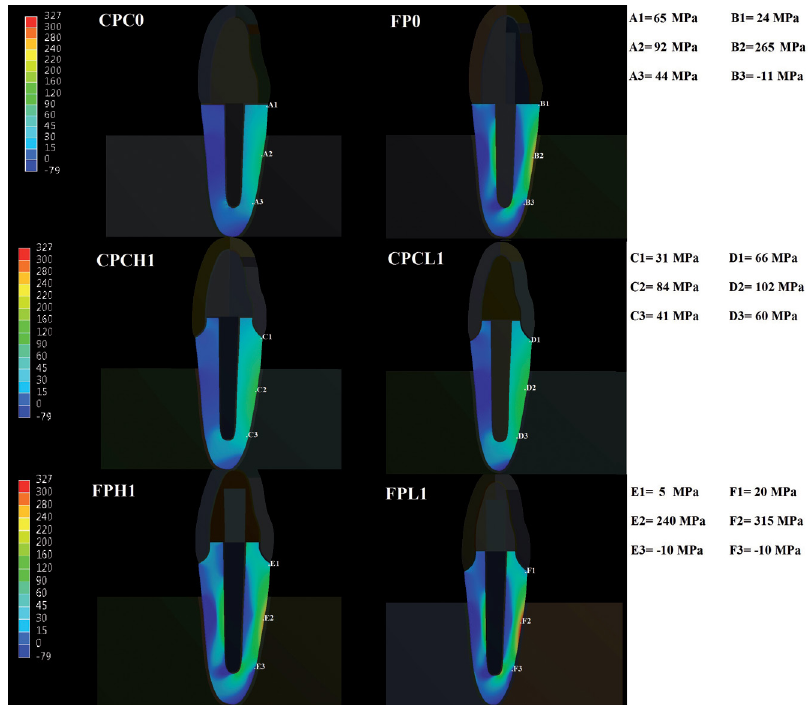
Figure 6- The images above shows: higher values of tensile stress at external portion of the root, in cervical and median third, in groups restored with fiber post (Fiber Post – FP0, Fiber Post higher than 1 mm – FPH1, Fiber Post lower than 1 mm – FPL1); higher values of tensile stress at apical third of root, in specimens restored with cast post and core (Cast Post and Core – CPC0, Cast Post and Core higher than 1 mm – CPCH1, Cast Post and Core lower than 1 mm – CPCL1) in comparison with roots restored with fiber